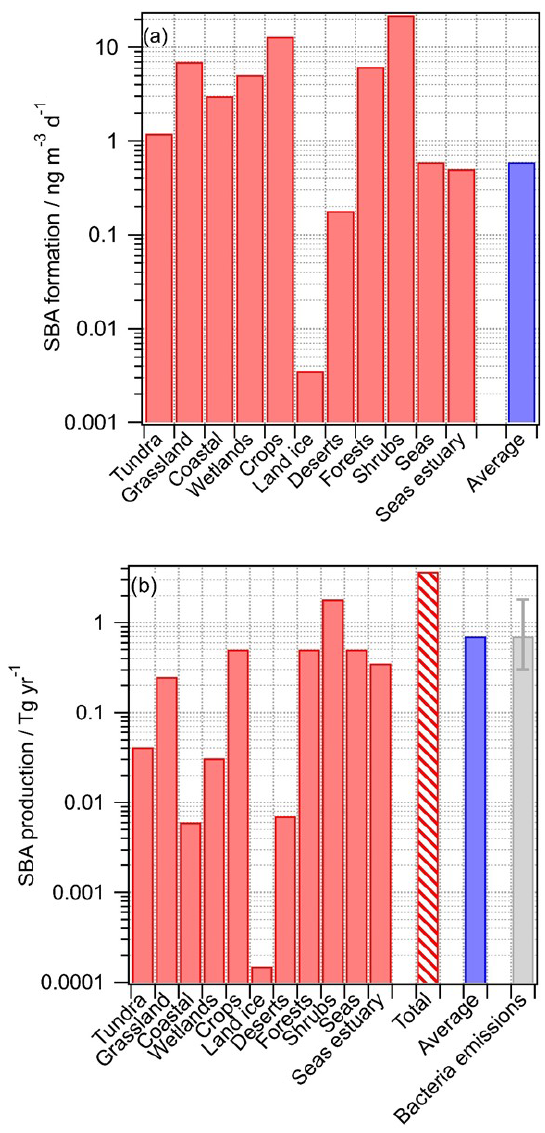
Figure 3. Predicted production of secondary biological aerosol (SBA) mass above various ecosystems. The blue bar indicates the predicted production using the average values for all ecosystems (“all” in Table 1); (a) SBA formation rates (ngm − 3 d − 1 ); (b) SBA production rates (Tgyr − 1 ). The red bar with hatching represents the sum of the contributions from all ecosystems; bacteria emissions are shown for comparison (taken from Burrows et al.,